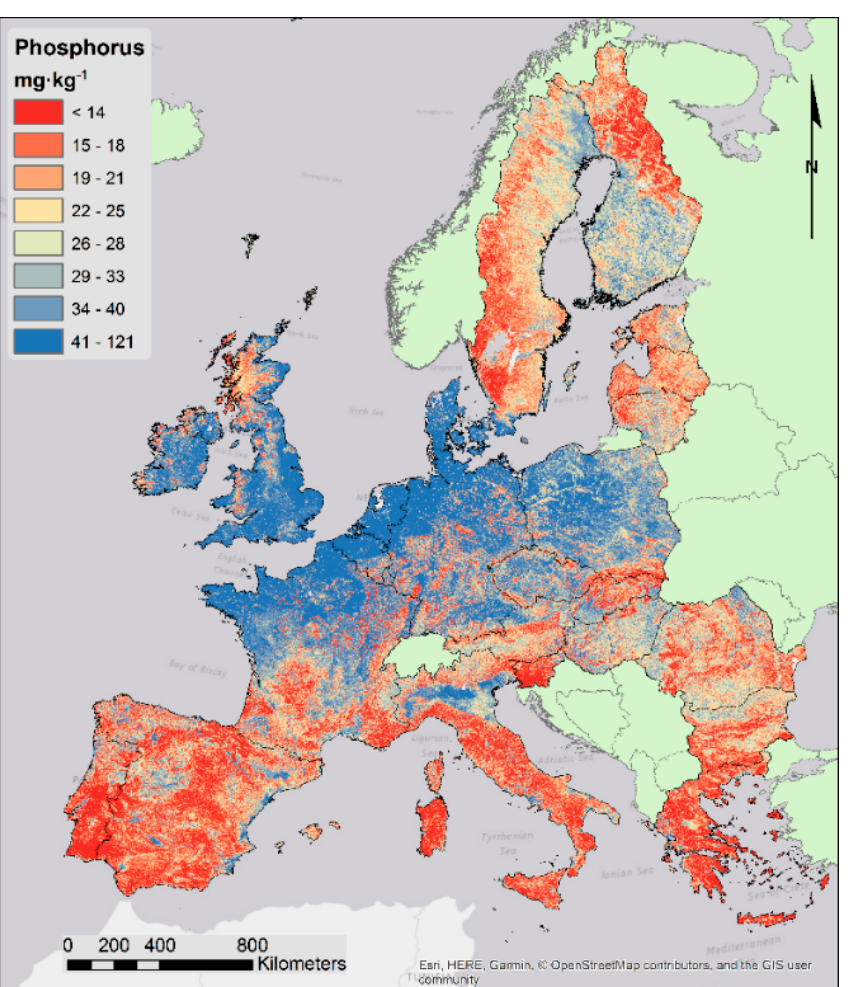
Figure 2. Topsoil phosphorus levels (Olsen P mg P/kg [44]) within the EU [45]. With permission from the author Cristiano Ballabio.